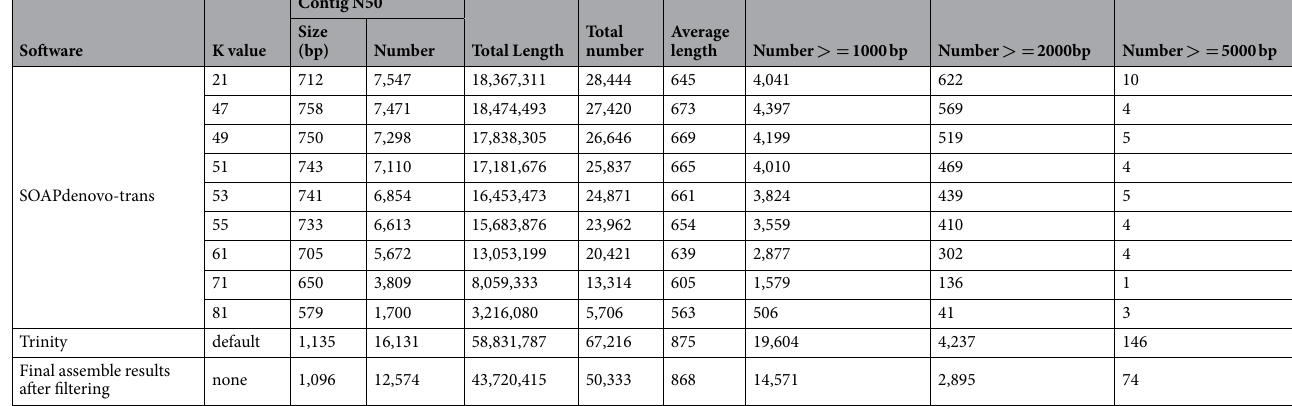
Table 1. Assembly results of SOAPdenovo-Trans, Trinity and results after